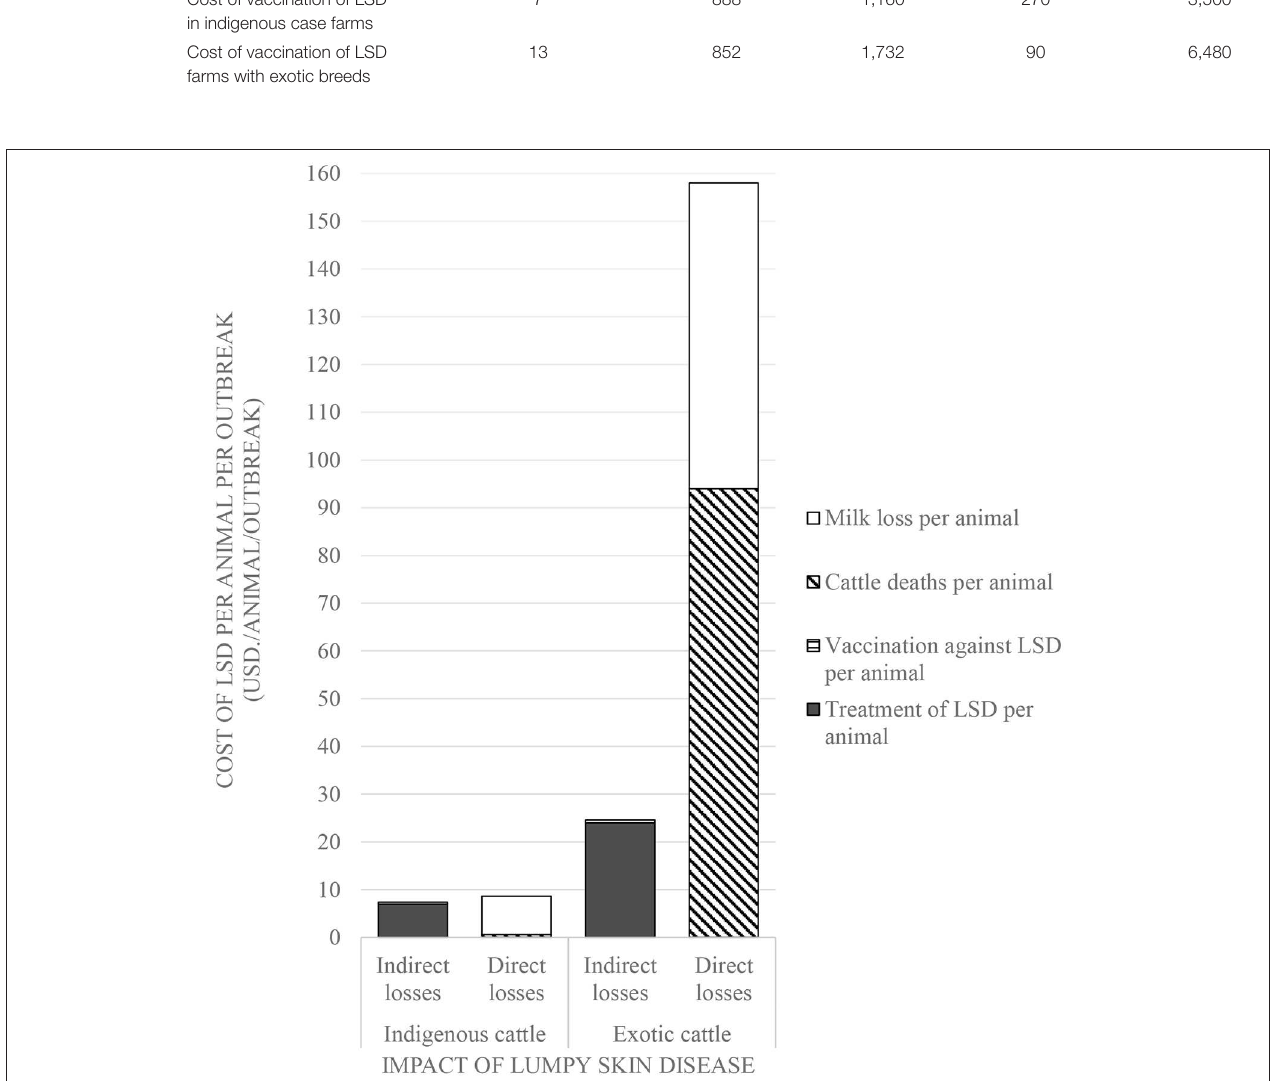
FIGURE 3 | Comparison of the economic impact of Lumpy Skin Disease outbreaks between indigenous and exotic breeds of cattle in Nakuru County, Kenya.